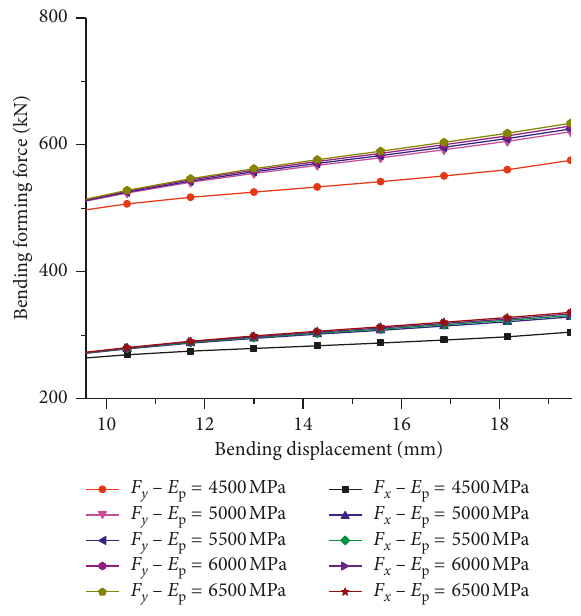
Figure 8: Partial enlargement of Figure 7.